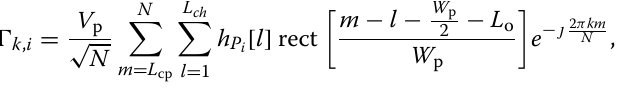
Fig. 7 Block Diagram representing the interference caused by the power signal x p h p m onto the information decoding chain at the IoT [ ]